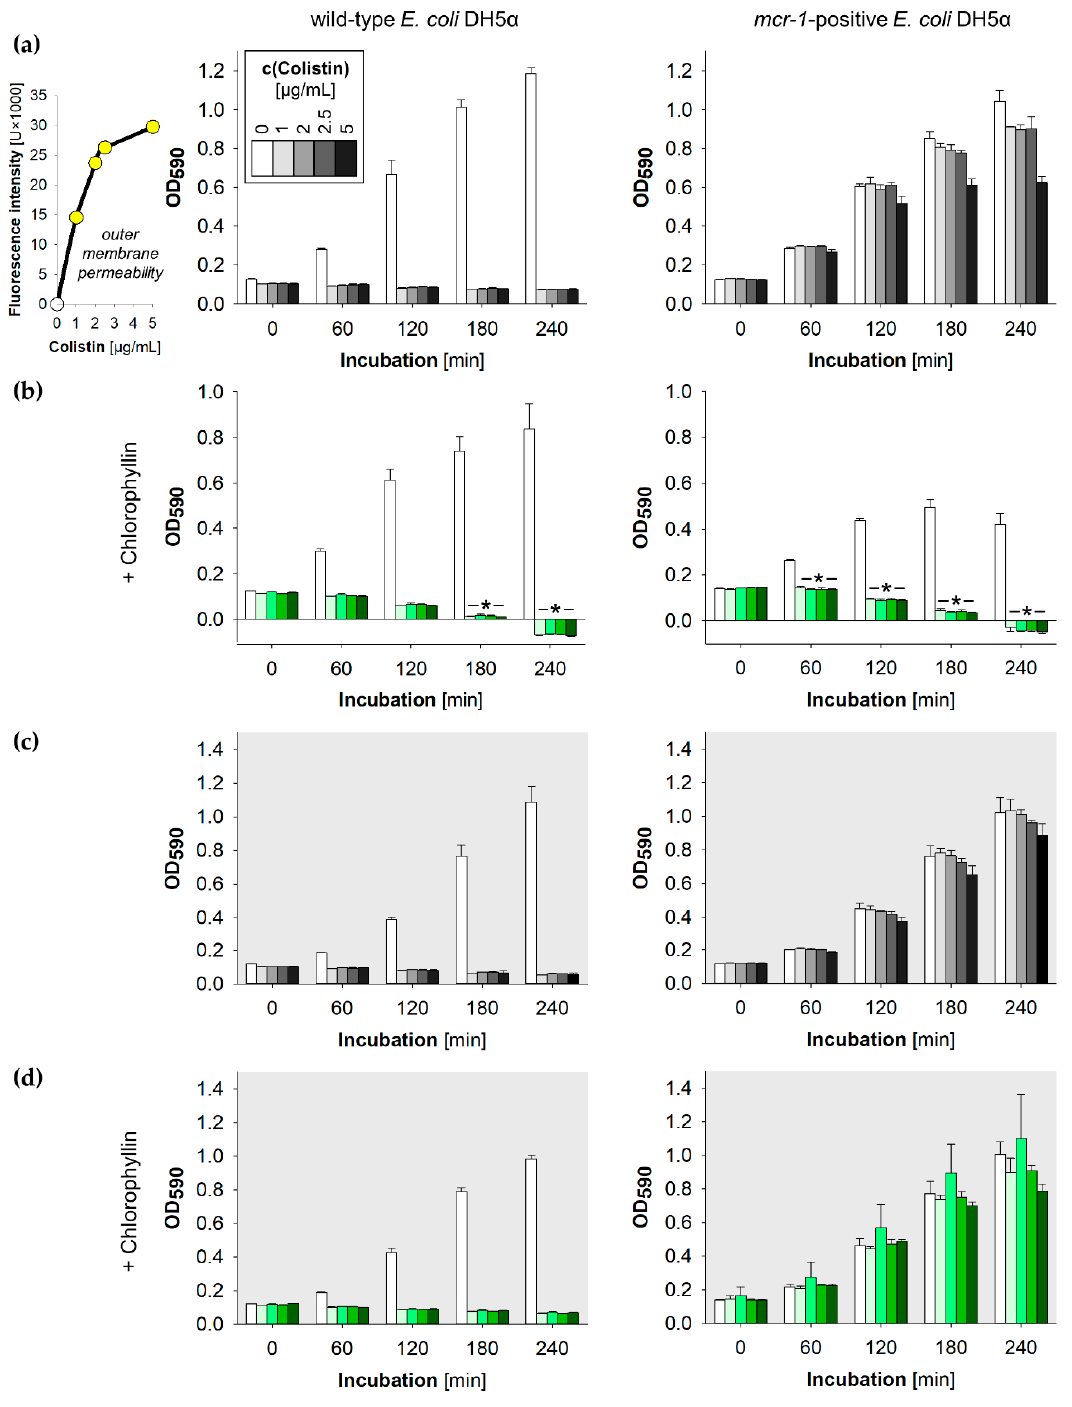
Figure 5. Growth of E. coli DH5 α (left column) and mcr-1 -positive E. coli DH5 α pGDP2: mcr-1 (right column) supplemented with different colistin concentrations; ( a,b ) cells were illuminated with a light intensity of 12 mW/cm 2 in absence ( a ) and presence ( b ) of 10 mg/L chlorophyllin. The outer membrane permeability was determined by using the NPN uptake assay; ( c,d ) cells were incubated protected from light in absence ( c ) and presence ( d ) of 10 mg/L chlorophyllin. Depicted are measured values ± standard deviations (n = 3) showing one representative of three independent experiments. *: p < 0.05 vs. chlorophyllin-free